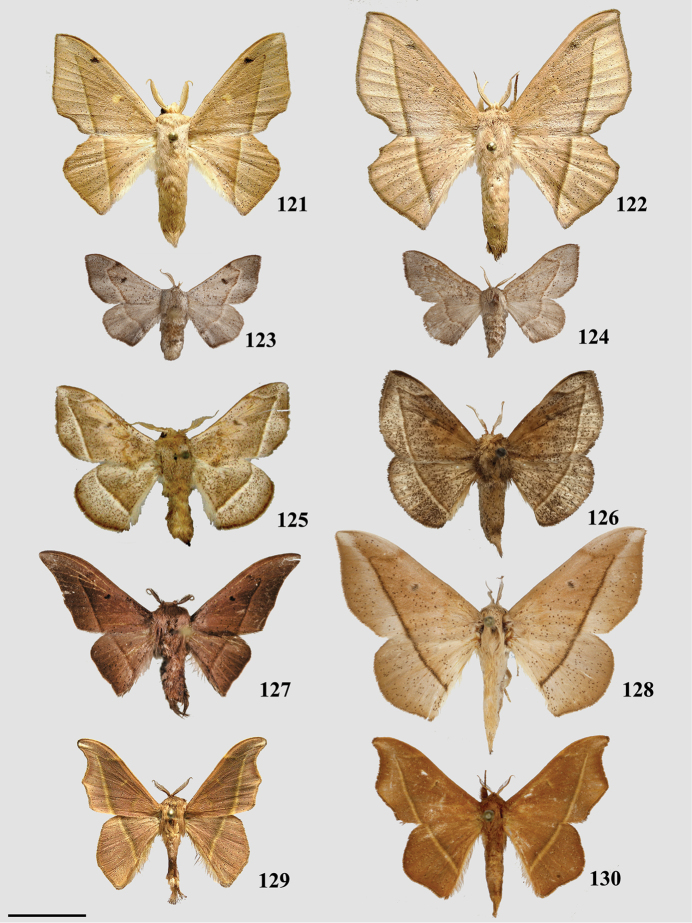
Adult specimens of type species of genera belonging to Druenticinae: Druenticini. 121Druenticapartha, male [reused with permission from St Laurent et al. (2018a), Systematic Entomology] (MNHN) 122D.partha, female [photo P Collet] (MNHN) 123Micrallominutus, holotype male [reused with permission from St Laurent and Mielke (2016), ZooKeys] (DZUP) 124M.minutus, paratype female [reused with permission from St Laurent and Mielke (2016), ZooKeys] (USNM) 125Pameaalbistriga, syntype male [photo A Giusti] (NHMUK) 126P.cfalbistriga, female (CUIC) 127Procinnuscahureli, holotype male [photo R Lahousse] (MNHN) 128P.cahureli, female [photo A Giusti] (NHMUK) 129Ulalumavalva, male [reused with permission from St Laurent and Cock (2017), Zootaxa] (MNHN) 130U.valva, female [reused with permission from St Laurent et al. (2018a), Systematic Entomology] (NHMUK). Scale bar: 1 cm.